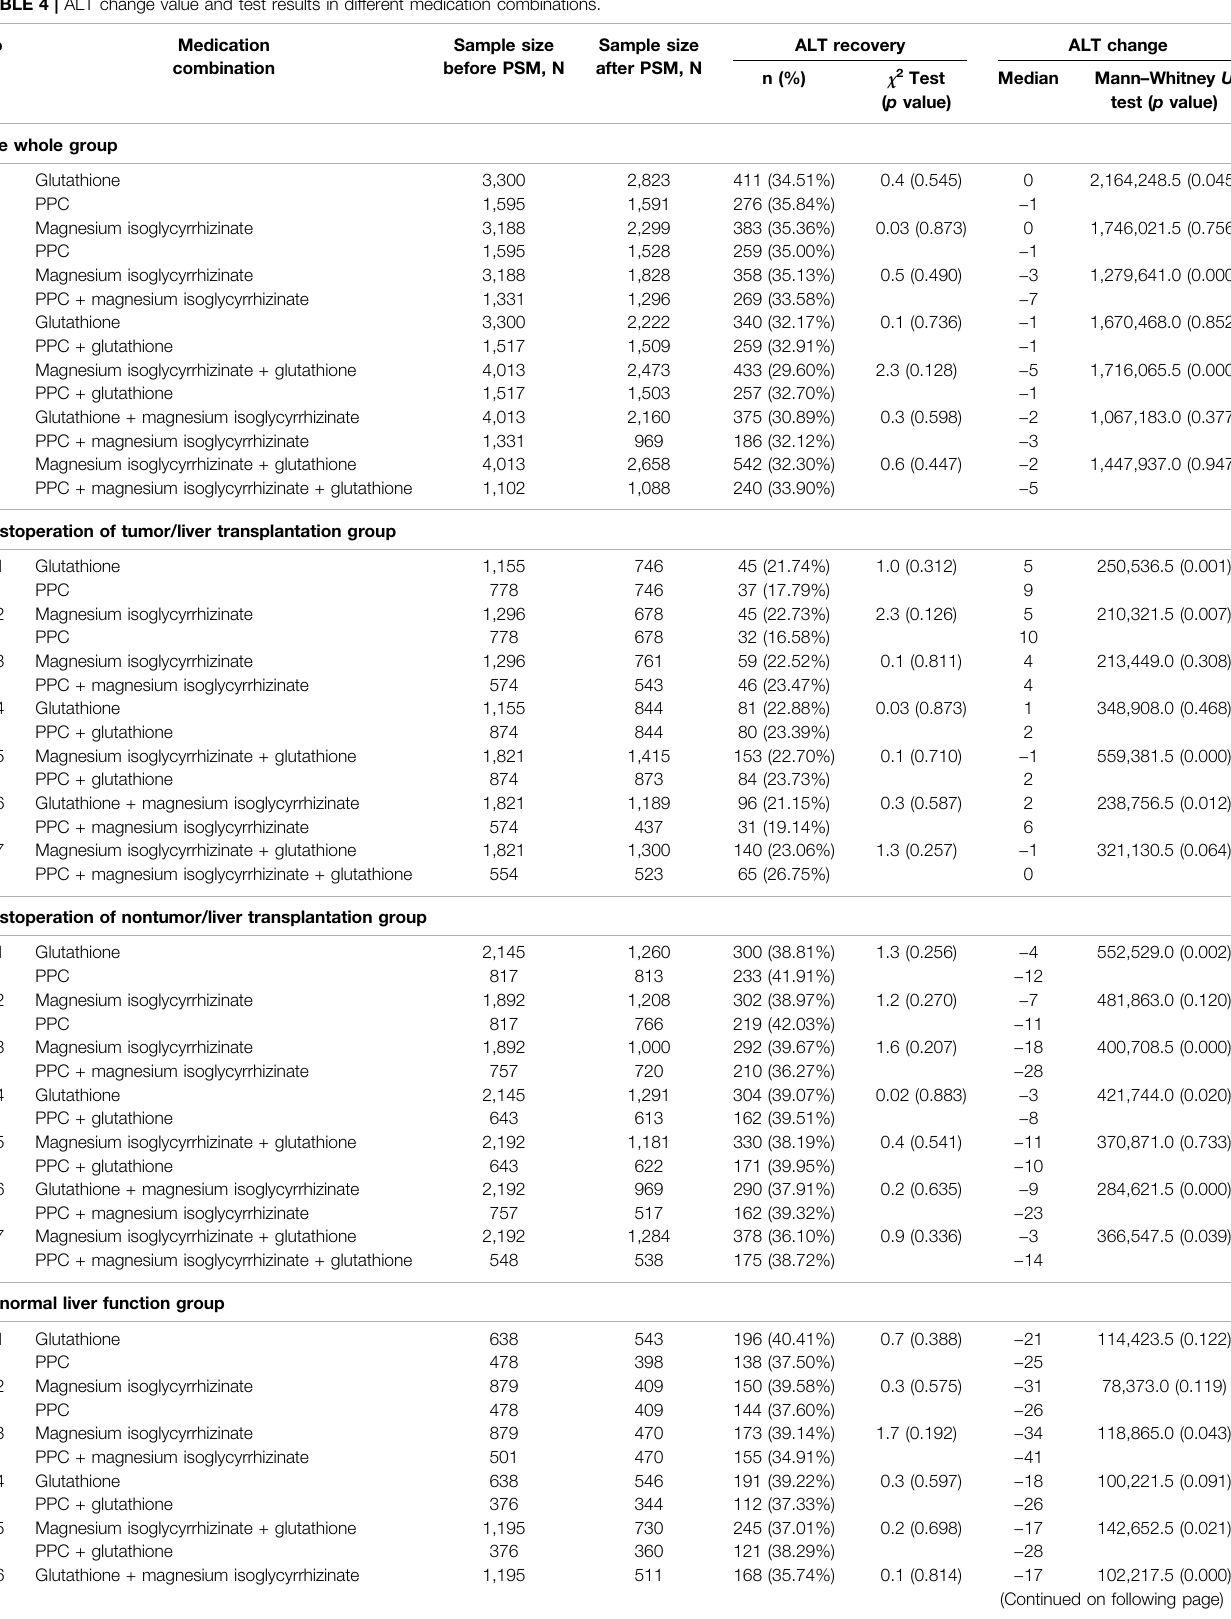
TABLE 4 | ALT change value and test results in different medication